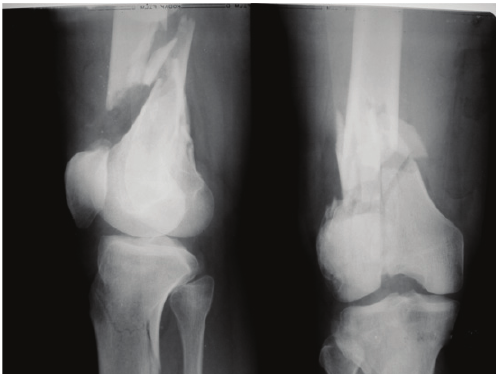
Figure 1: Preoperative X-ray of the right knee AP and lateral views showing fracture distal femur and proximal tibia.